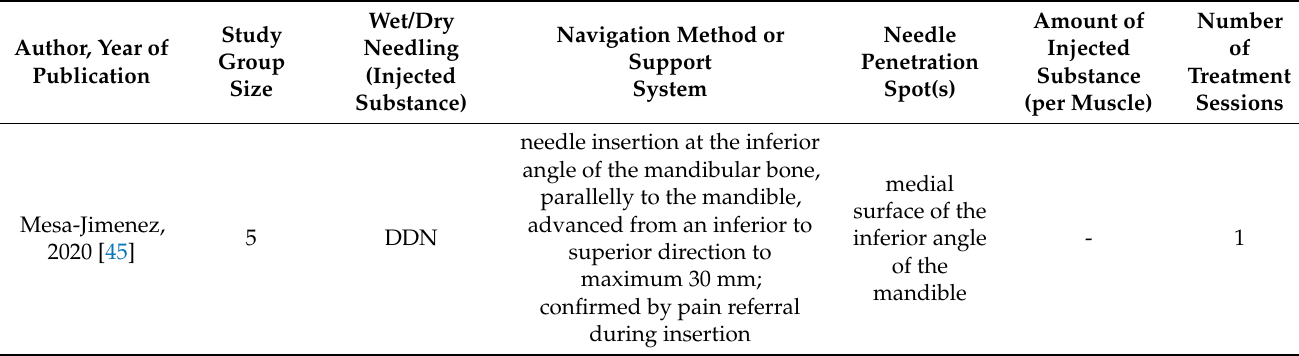
Table 6. Studies regarding medial pterygoid muscle